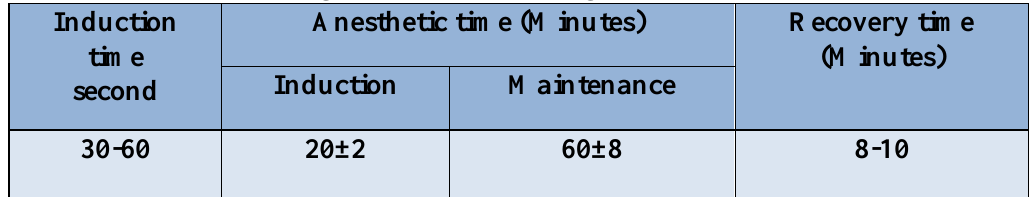
Table (1): The time of general anesthetic regime.